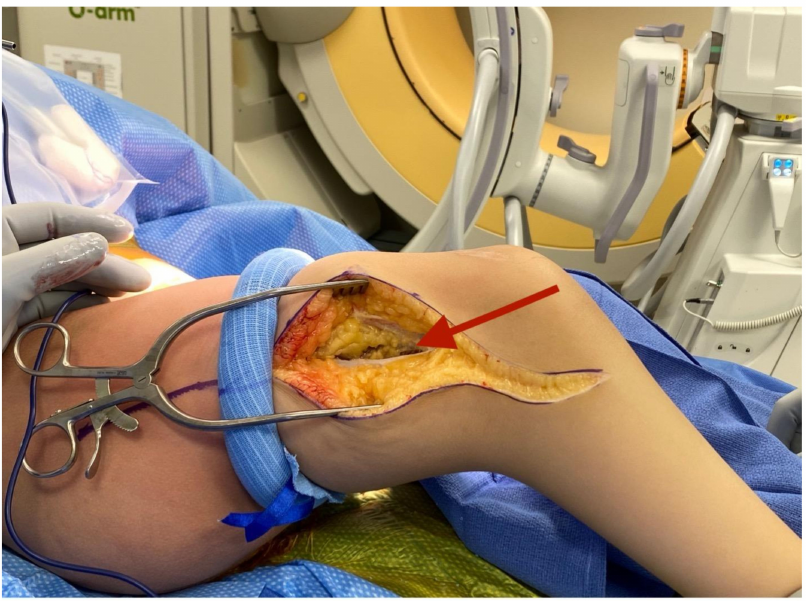
Figure 2. Iliotibial band incised and raised off quadriceps membrane.